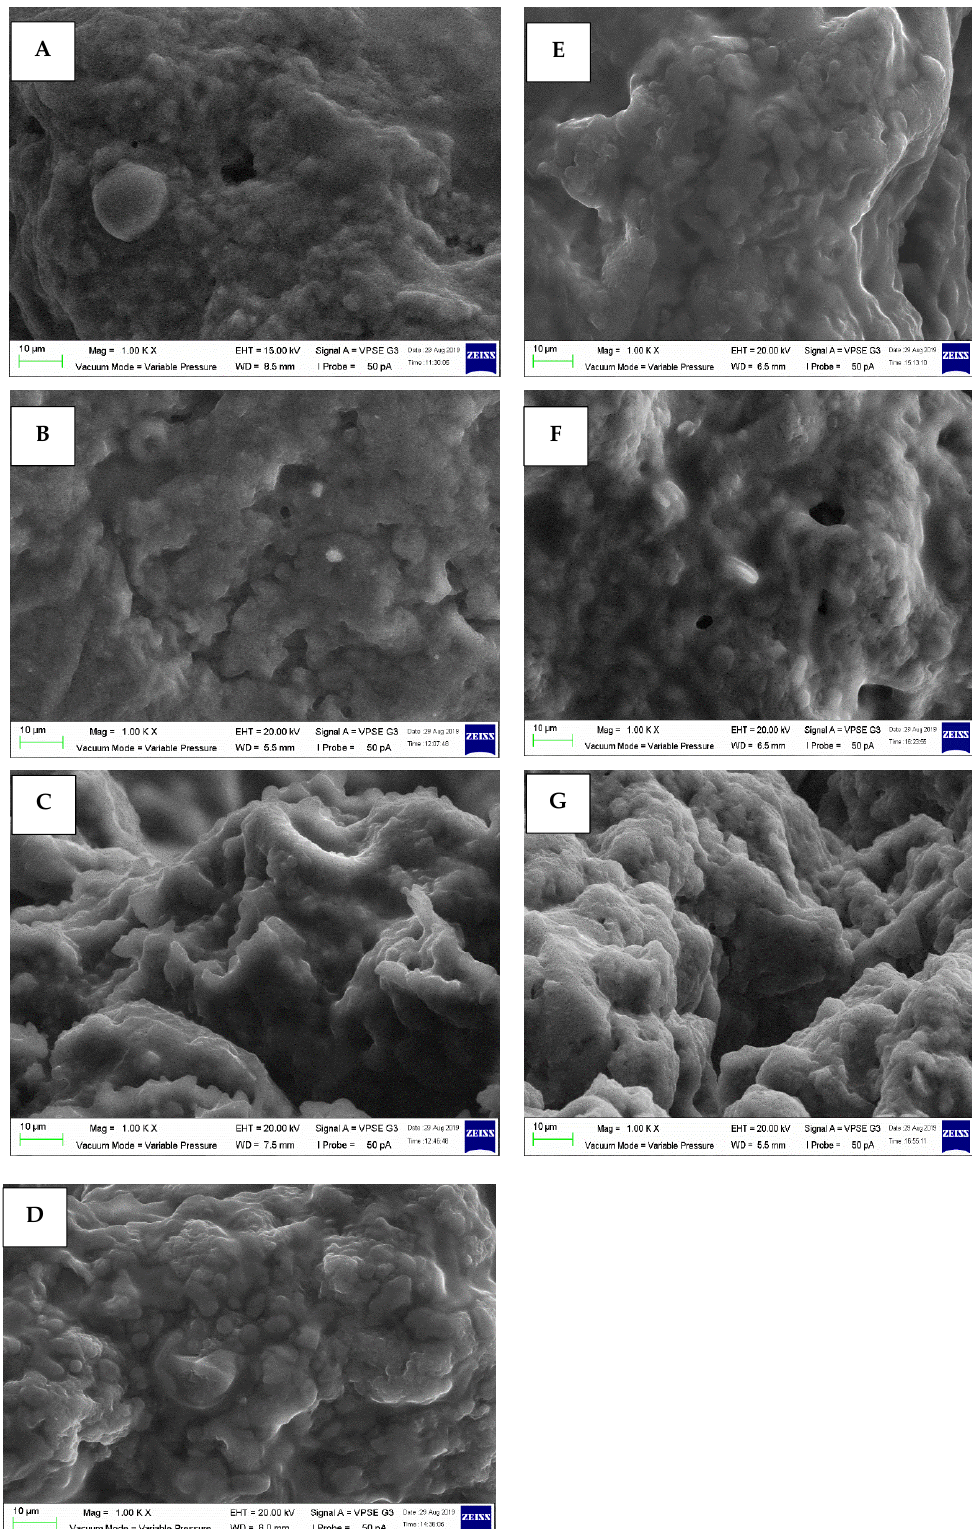
Figure 4. Microstructure of chicken sausage added with banana peel flour. ( A ) Control; ( B ) Sausage with 2% Saba banana peel flour; ( C ) Sausage with 4% Saba banana peel flour; ( D ) Sausage with 6% Saba banana peel flour; ( E ) Sausage with 2% Berangan banana peel flour; ( F ) Sausage with 4% Berangan banana peel flour; ( G ) Sausage with 6% Berangan banana peel flour.